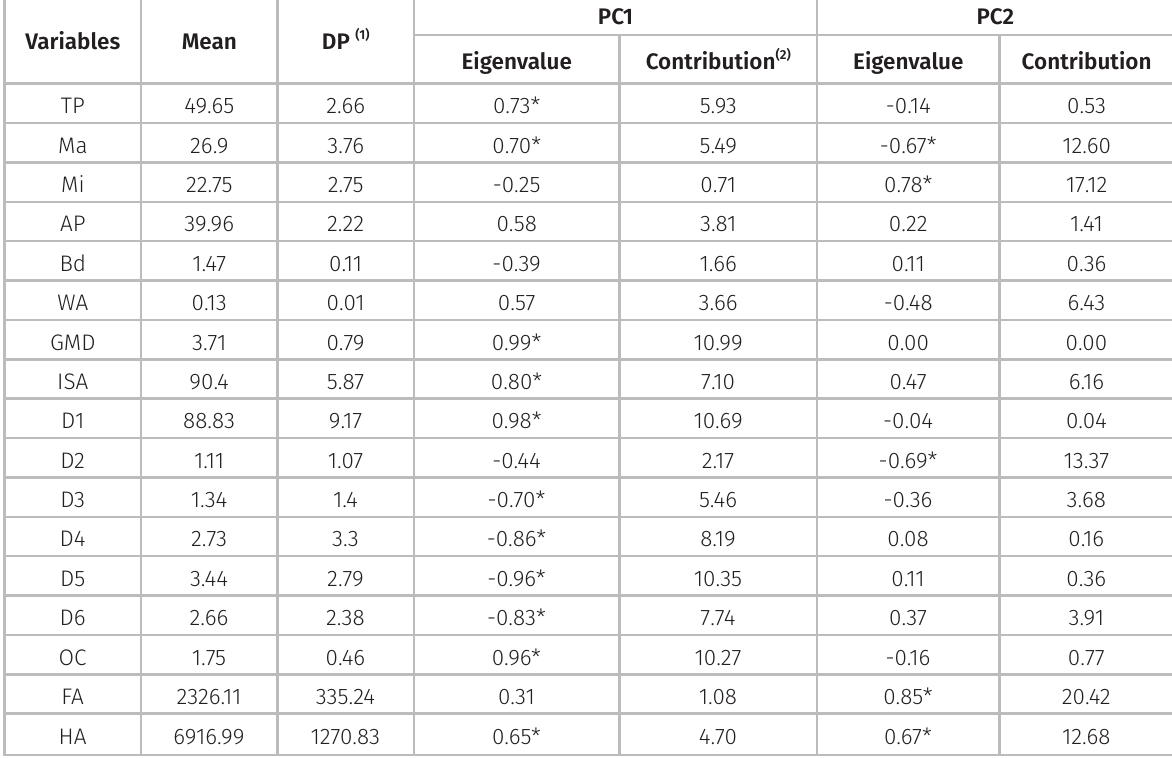
Table V. Descriptive statistics, correlations and contribution among the parameters evaluated for the Yellow Latosol with the first two main components for the analyzed